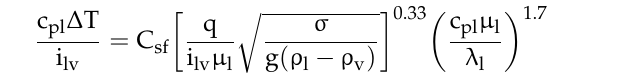
Figure 10. Comparison of the experimental data to the correlations, plain surface. ( a ) Pool boiling heat transfer; ( b ) boiling curves.